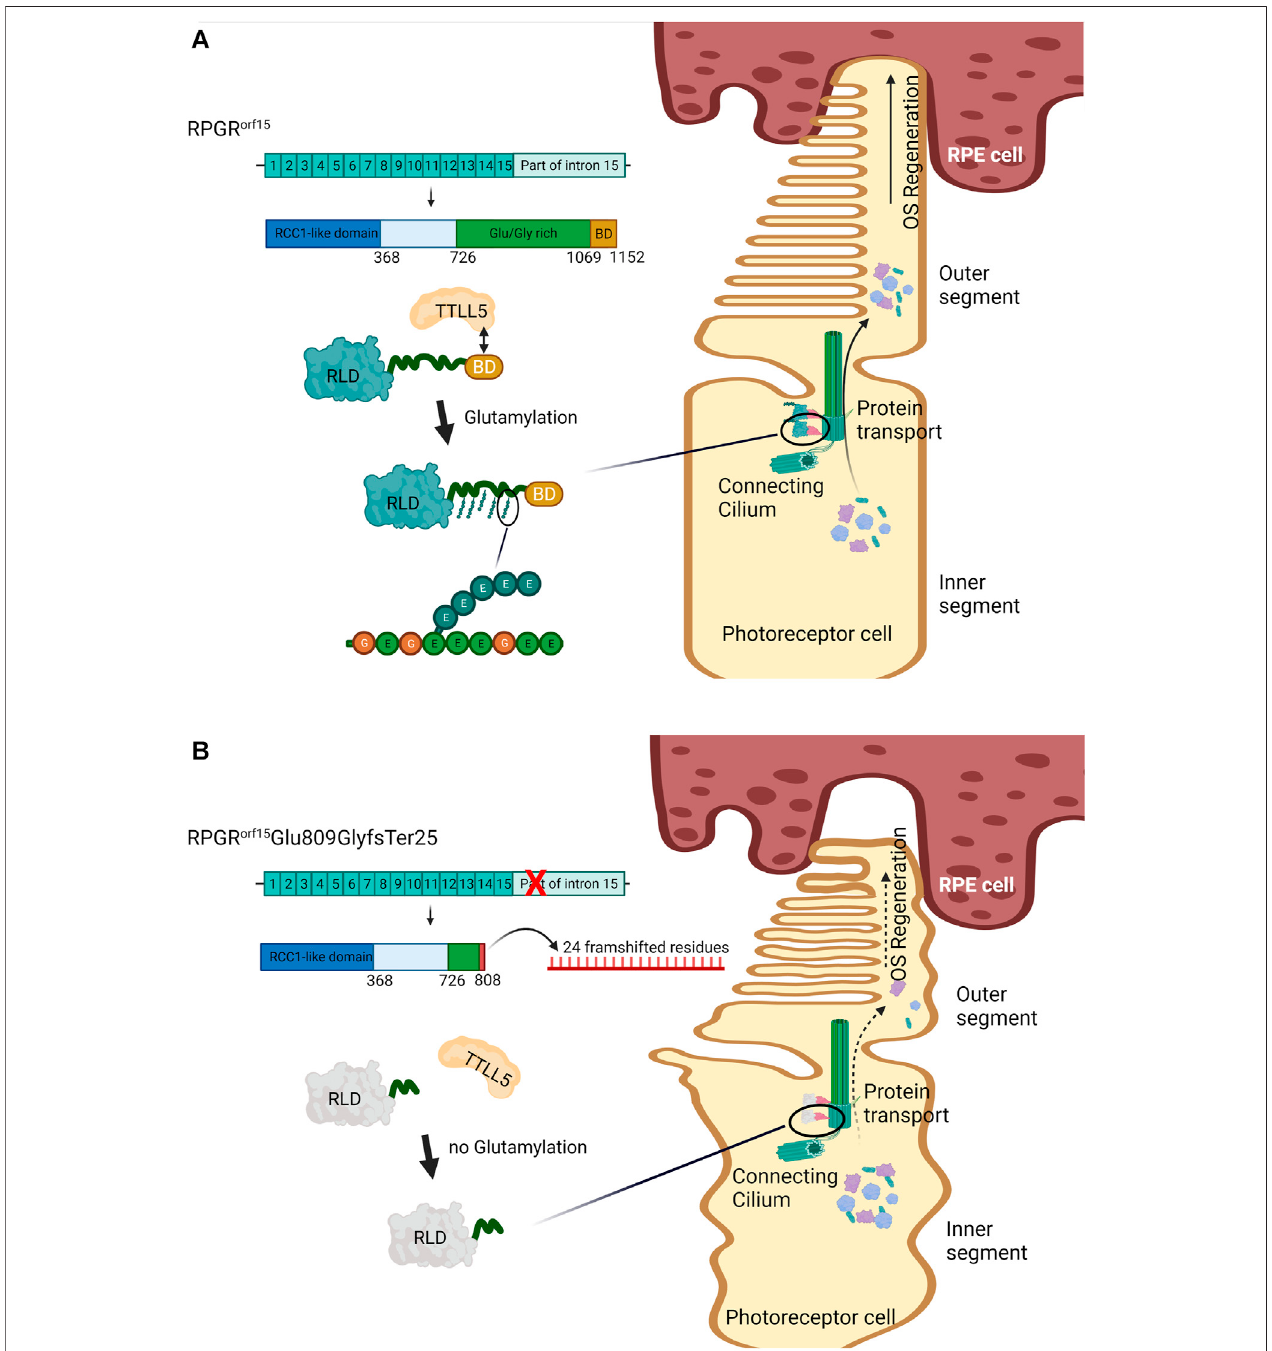
FIGURE4| EffectoftheglutamylationontheRPGR ORF15 wildtypeandRPGR ORF15 Glu809GlyfsTer25. (A) Thewildtype RPGR ORF15 proteinusesthebasicdomain (BD) to interact with Tubulin Tyrosine Ligase-Like 5 (TTLL5). The TTLL5 induces glutamylation to the repetitive amino acid sequence on the Glu/Gly-rich region at the C-terminus of RPGR ORF15 . The glutamylated RPGR ORF15 at the connecting cilium performs its role in protein traf fi cking, allowing effective transportation of opsins and other proteins from the inner (IS) to the outer segment (OS), which is critical for the regeneration of the OS and photoreceptors survival. (B) The mutant RPGR ORF15 Glu809GlyfsTer25,lackingtheBDandmostofGlu/Gly-richregion,couldnotinteractwithTTLL5andundergoglutamylation.Themutantperformspoorlyon protein transportation, impairing the OS regeneration and photoreceptor vitality. The image was created with BioRender.com. BD: basic domain, OS: outer segment, RCC-1: regulator of chromosome condensation 1, RLD: RCC1-like domain, RPE: retinal pigment epithelium, RPGR: retinitis pigmentosa GTPase regulator, TTLL5: Tubulin Tyrosine Ligase-Like 5